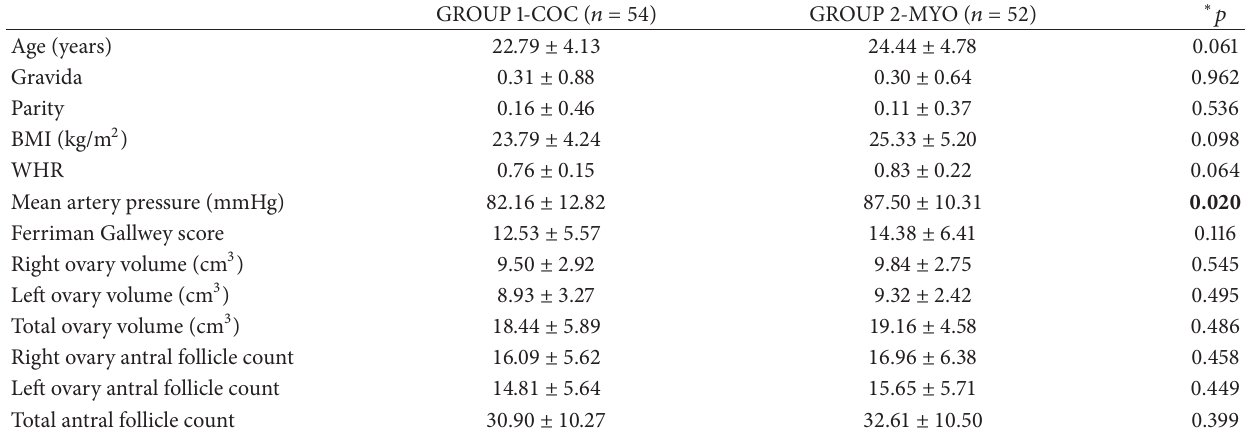
Table 1: Comparison of demographic and clinical characteristics of group 1 and group